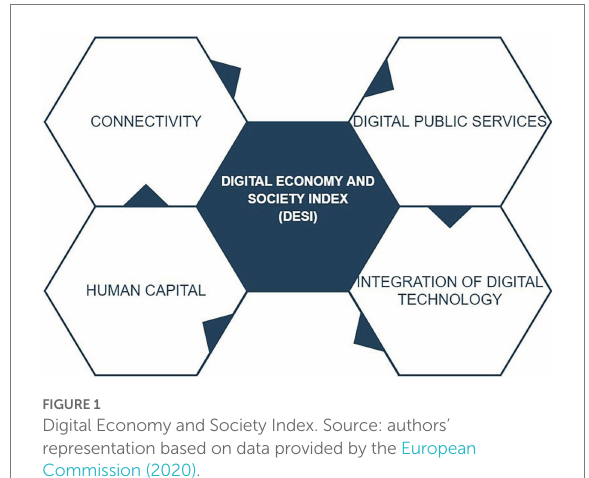
FIGURE 1 Digital Economy and Society Index. Source: authors’ representation based on data provided by the European Commission